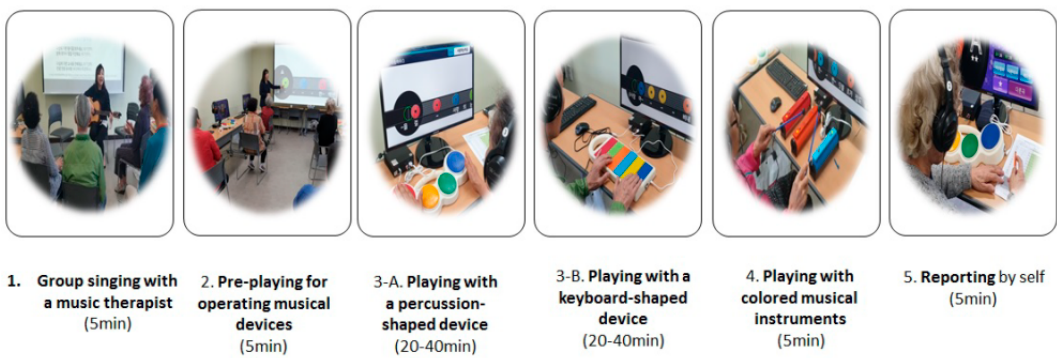
Figure 5. Five progressive steps of each session. Constructive processes included were group singing with a music therapist, pre-playing in a group, playing with therapeutic musical devices as therapeutic cognitive intervention, and self-reporting of experiences of each session.